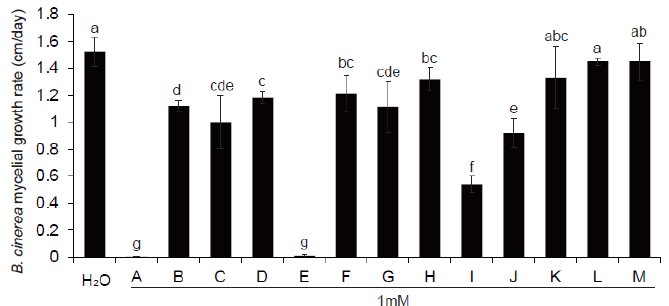
Figure 7. Effect of 13 compounds (A – M; Table 1; 1 mM) on the mycelial growth of B. cinerea . The same lowercase letters indicate that the difference was not significant at p < 0.05, according to Duncan’s multiple range tests.